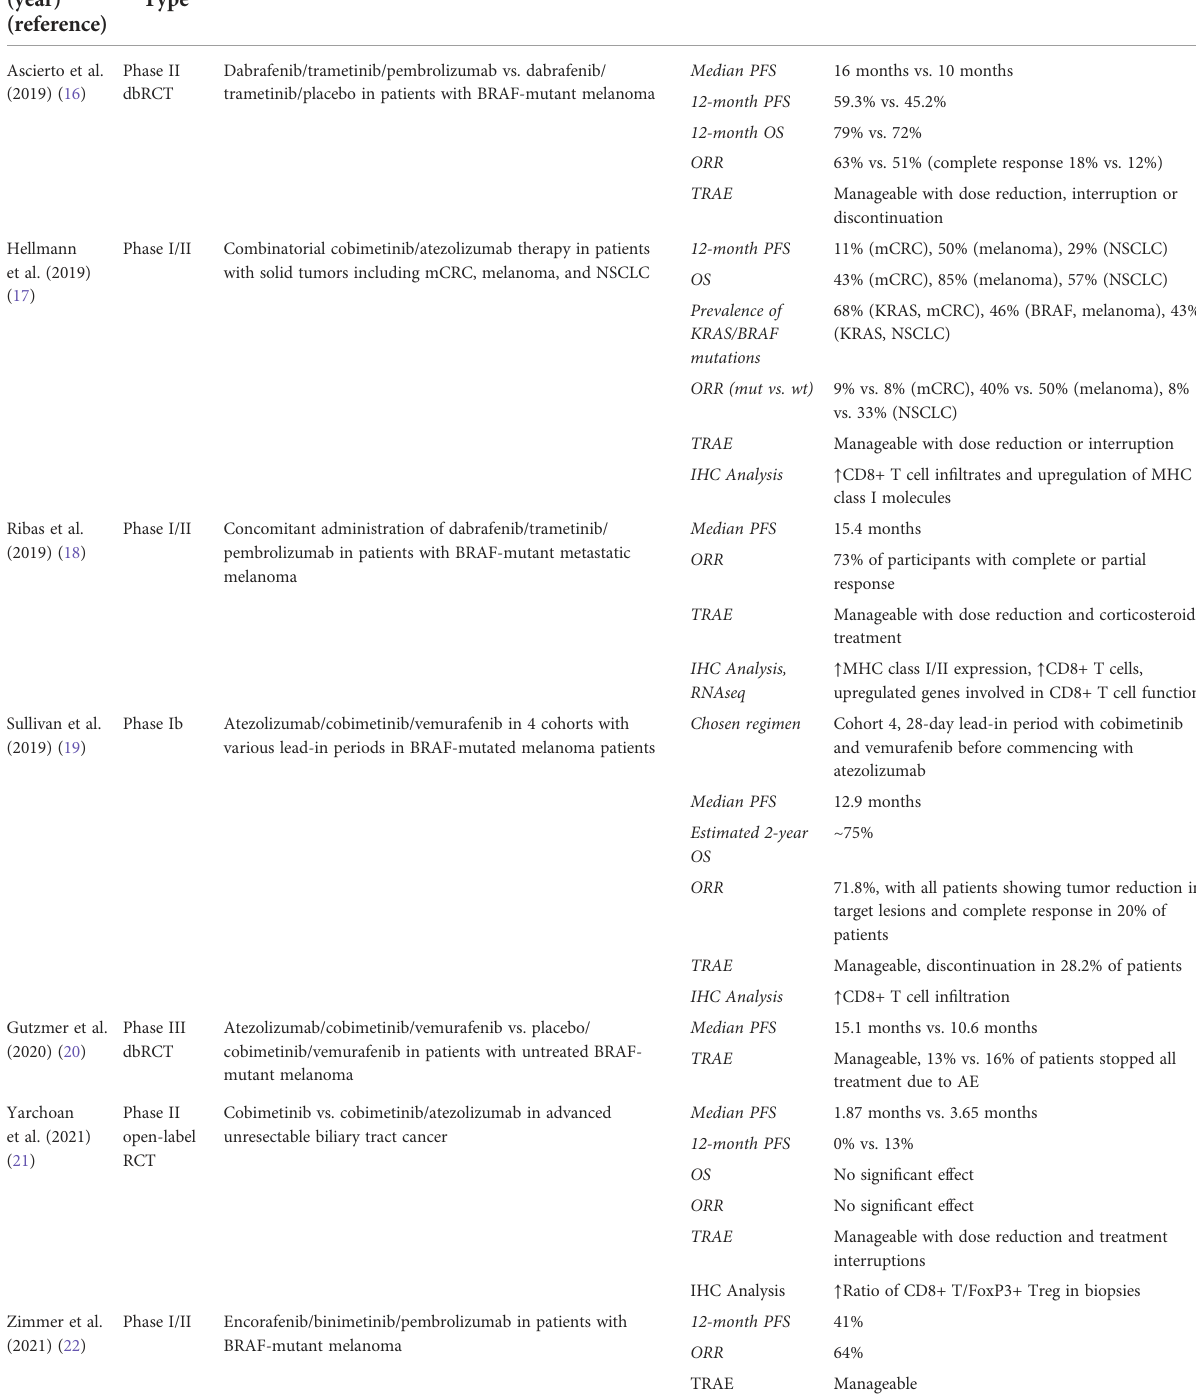
TABLE 1 Results from selected completed clinical trials investigating MEK inhibition as part of dual and triple therapy regimens in patients with KRAS-/BRAF-mutant solid tumors and